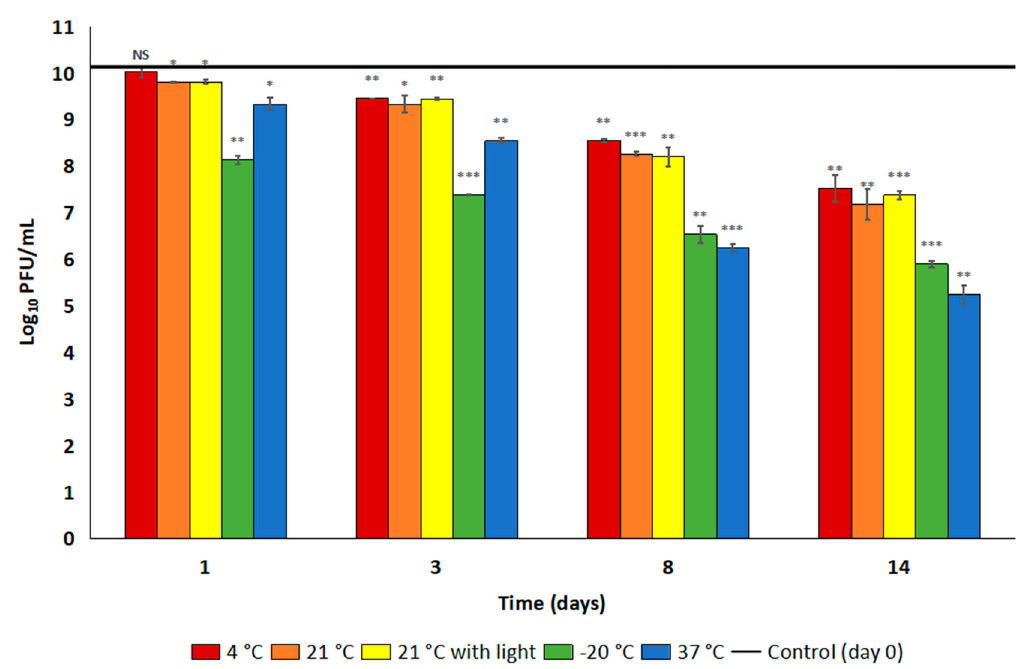
Figure 4. Logarithmic titre of vPhT2 after storage in SM buffer II or LB for 14 days in different temperature and light conditions compared to day zero. (NS = no significance, * p < 0.05, ** p < 0.01, *** p < 0.001).